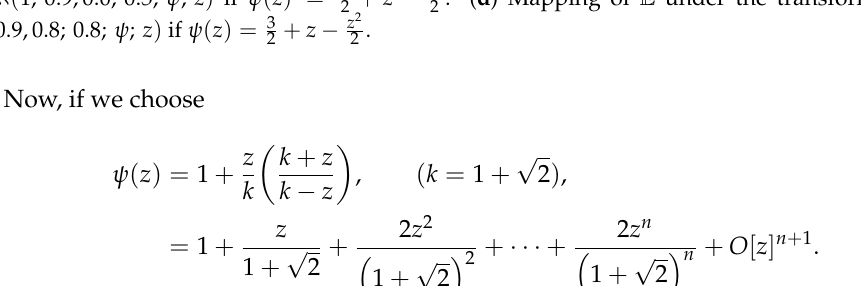
+ z − z 2 . ( a ) Mapping 2 2 + z − z 2 . ( b ) Mapping of E under the transfor- 2 2 + z − z 2 . ( c ) Mapping of E under the 2 2